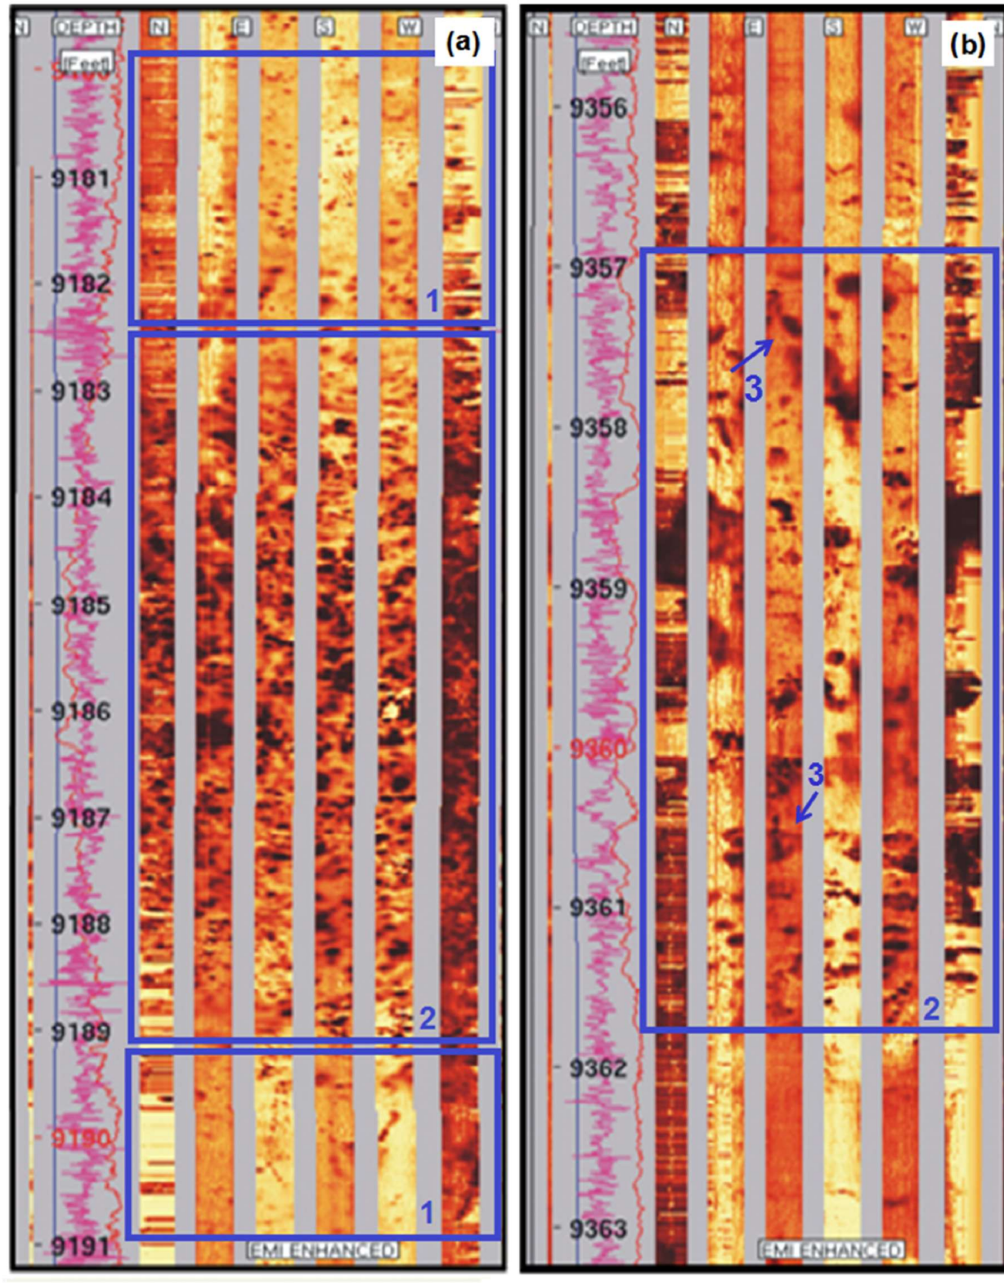
Figure 8. FMS log showing secondary porosity structures observed in Tourmaline-1X well ( a ) 9180–9191 ft and ( b ) 9356–9363 ft. 1: Many small poorly-interconnected vugs at 9180–9182.5 ft and 9189–9191 ft; 2: Multiple interconnected vugs at 9182.5–9189 ft and 9357–9362 ft 3: Dissolution channels (indicated by the